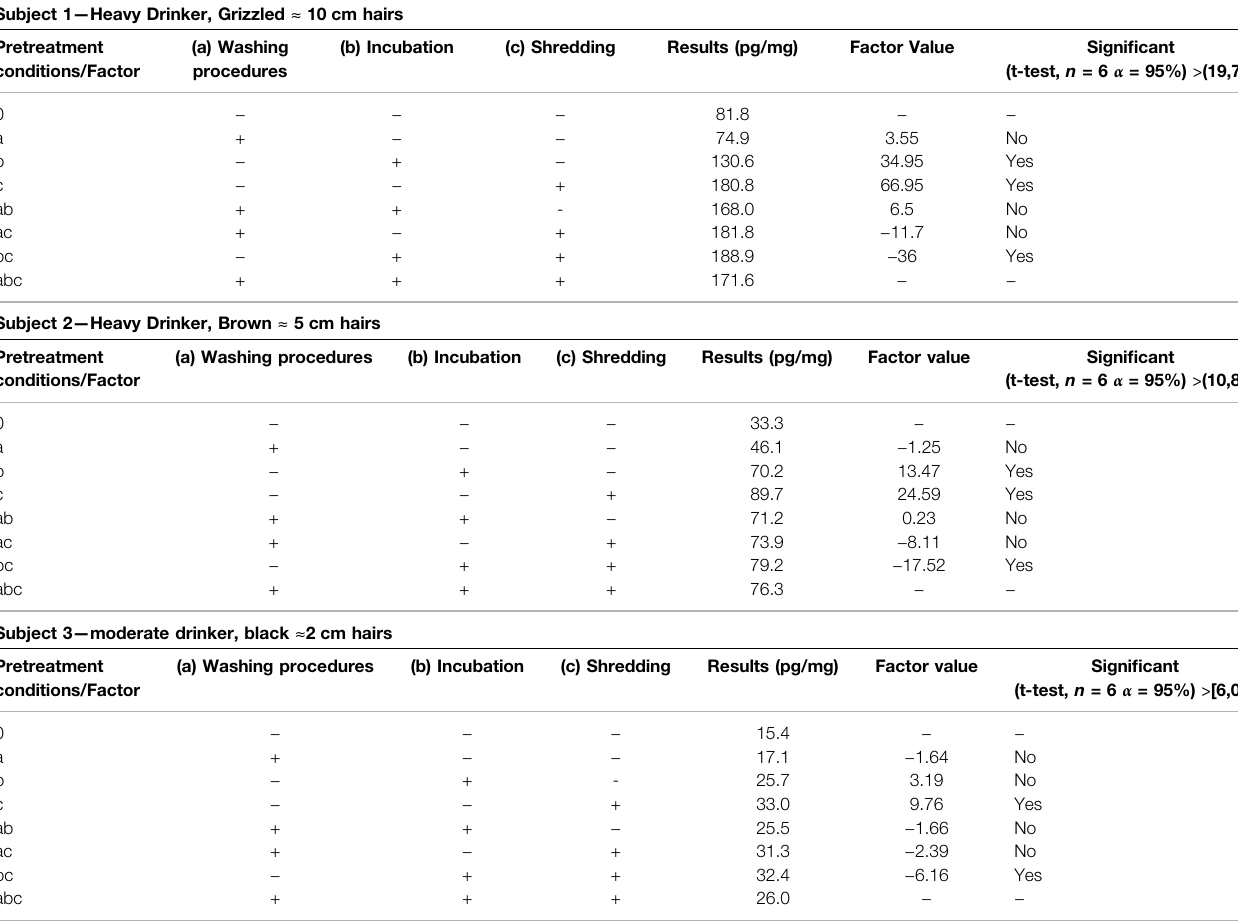
TABLE 3 | Factorial DoE results applied to the hair of three subjects. Subject 1 — Heavy Drinker, Grizzled ≈ 10 cm